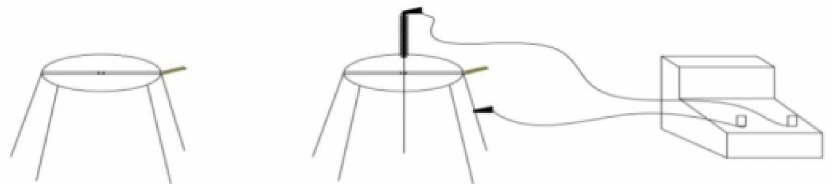
Figure 2. Drawing of the simple single-point electroacupuncture (SEA) frame. From left to right are the electroacupuncture rack, single point electroacupuncture frame and electroacupuncture apparatus.